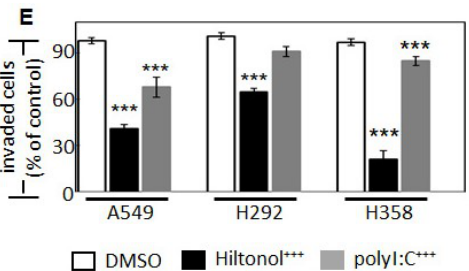
Figure 3. Hiltonol +++ efficiently suppressed lung cancer migration and invasion. The effects of Hiltonol alone or polyI:C alone or their respective combinatorial treatments (with anti-IL6+stattic+AG490) on metastatic potential in lung cancer were examined by migration assay: ( A ) A549 ( B ) H292 ( C ) H1299 and ( D ) H358 cells. The rate of migration was quantified as % gap closure normalized to corresponding 0 h time point DMSO-treated controls. Compared with polyI:C +++ (polyI:C+anti-IL6+stattic+AG490)- treated cells, the Hiltonol +++ (Hiltonol+anti-IL6+stattic+AG490)-treated cells displayed significant delay in migration, particularly for A549, H292, and H358 cells. In earlier time points (12 h or 16 h), the LSD value in A549, H292, H1299, and H358 are 1.876, 2.048, 1.697, and 2.247, respectively. In later time points (either 24 h or 36 h), the LSD value in A549, H292, H1299, and H358 are 2.17, 1.724, 0.83, and 2.799, respectively. **, p < 0.01; ***, p < 0.001. ( E ) shows cell invasion of these three cell lines. PolyI:C +++ reduced invasion of A549 and H358 by 30% and 12%, respectively, whereas Hiltonol +++ further abrogated cell invasion of A549, H292, and H358 cells by 57%, 36%, and 76%, respectively. ***, p < 0.001. The LSD value in A549, H292, and H358 are 10.187, 9.967, and 11.004,